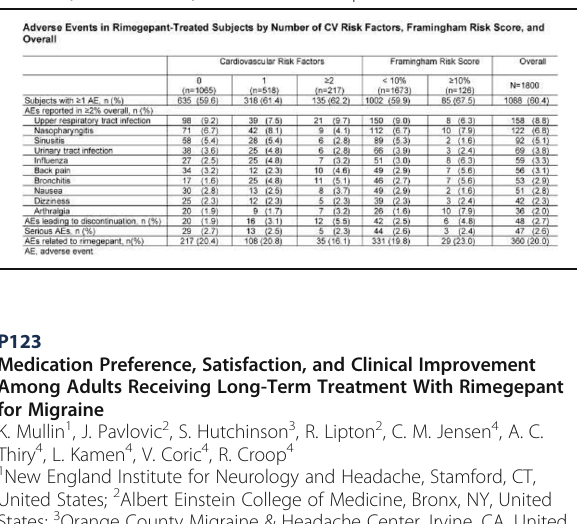
Table 1 (abstract P122). See text for description.